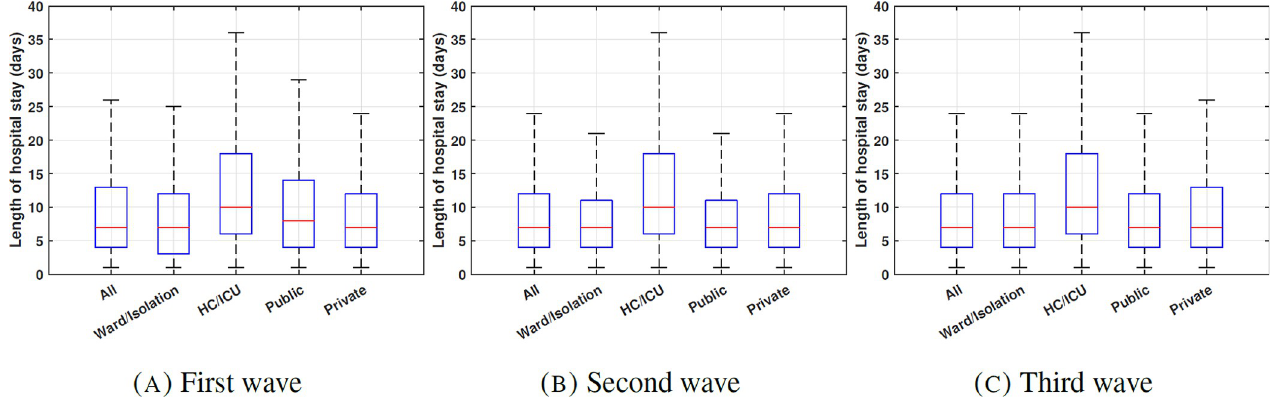
Fig 2. Distribution of the length of hospital stay during the first, second, and third wave of the pandemic.